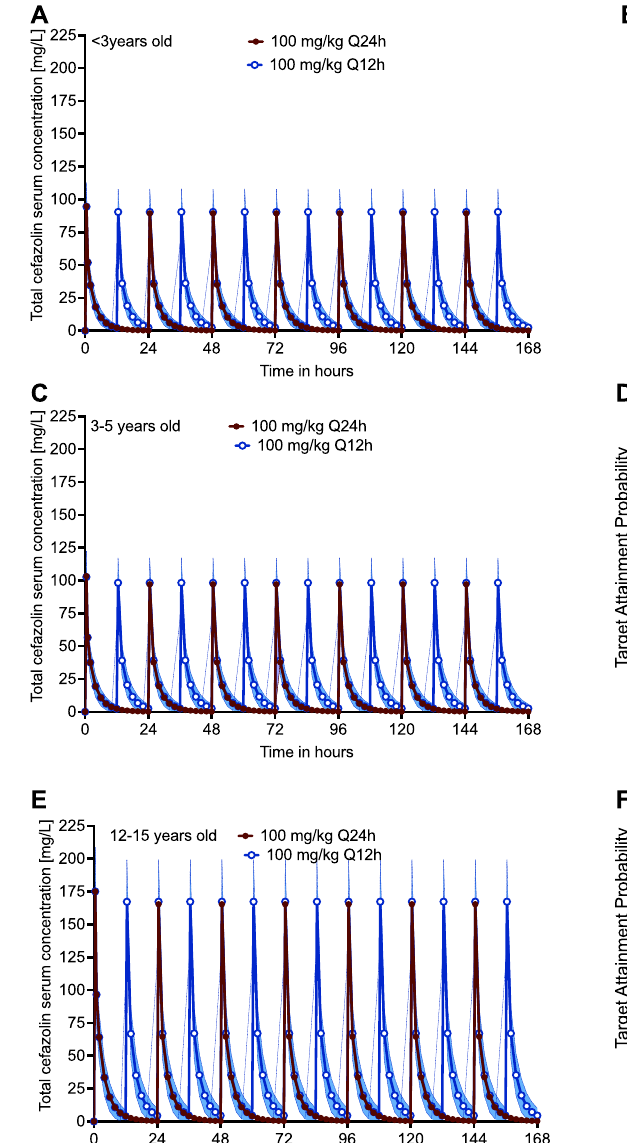
Frontiers in Pharmacology |